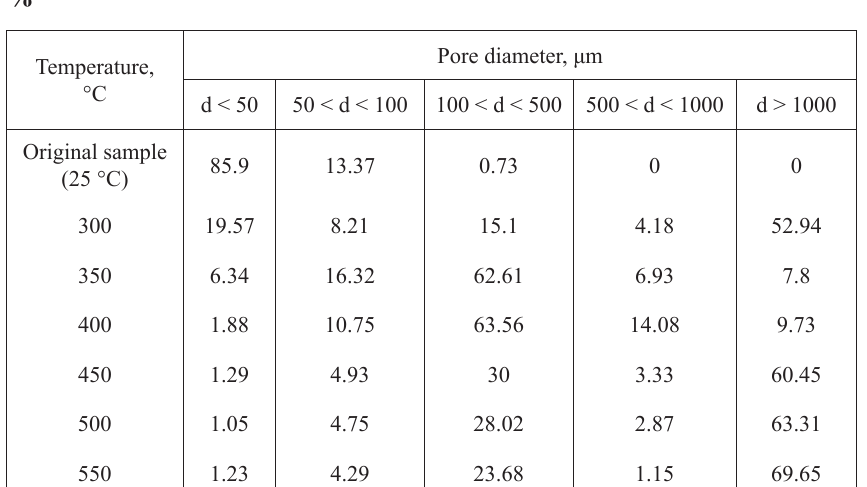
Table. 3. Volume percentage of pores with different diameters in total pore space,